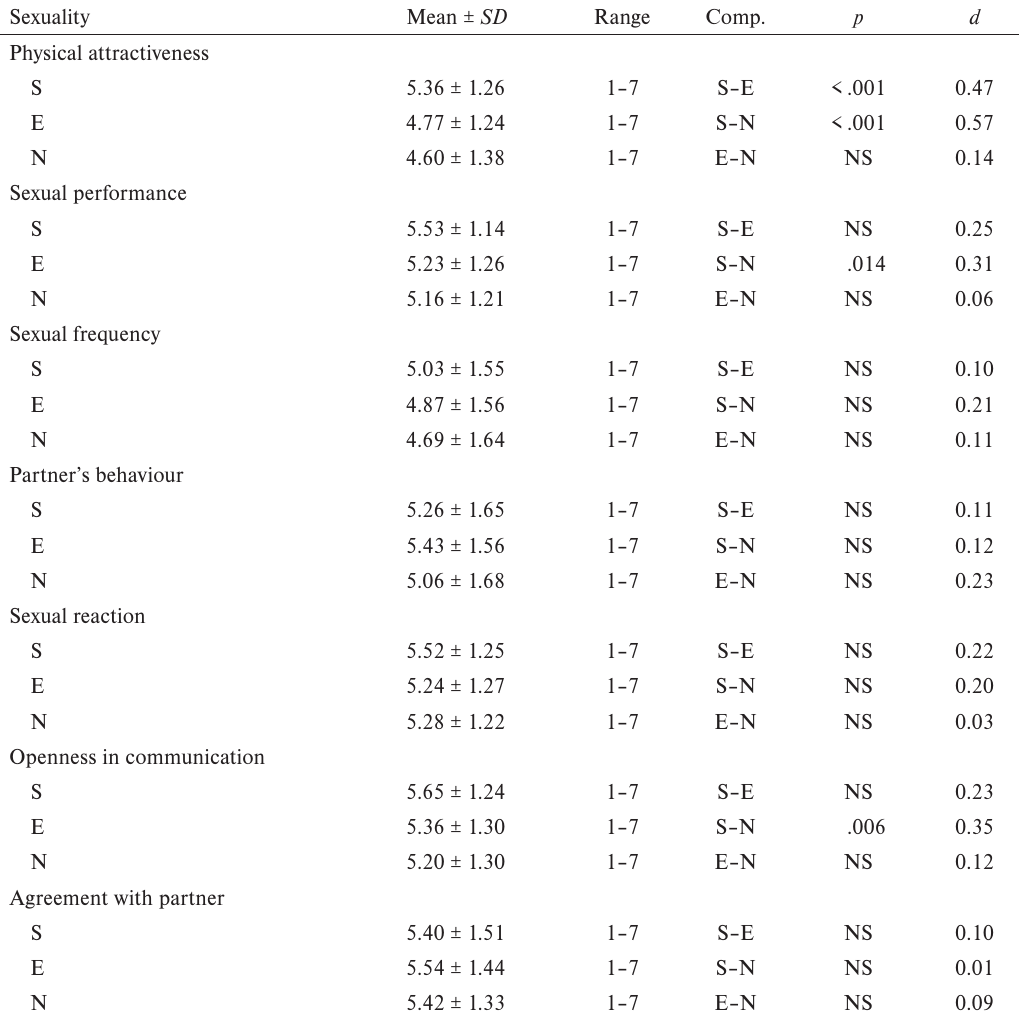
Table 5 Comparison of life satisfaction in the area of sexuality in current university students with respect to study